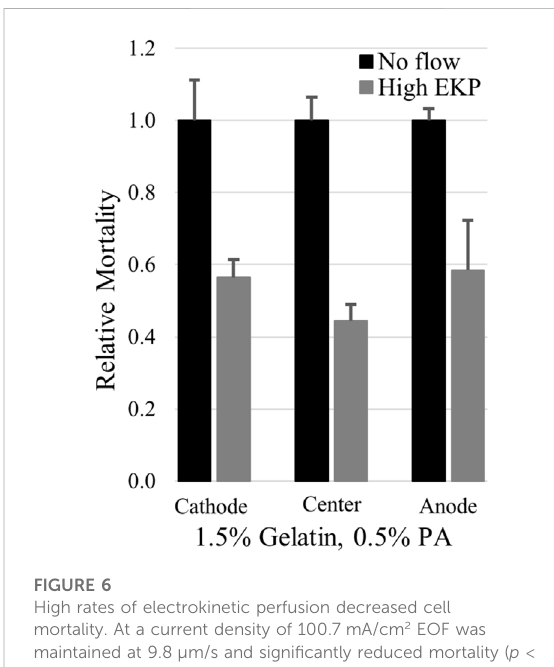
FIGURE 6 High rates of electrokinetic perfusion decreased cell mortality. At a current density of 100.7 mA/cm 2 EOF was maintained at 9.8 μ m/s and signi fi cantly reduced mortality ( p < 0.005 cathode, p < 0.001 center, p < 0.02 anode) compared to the cells in the absence of fl ow.